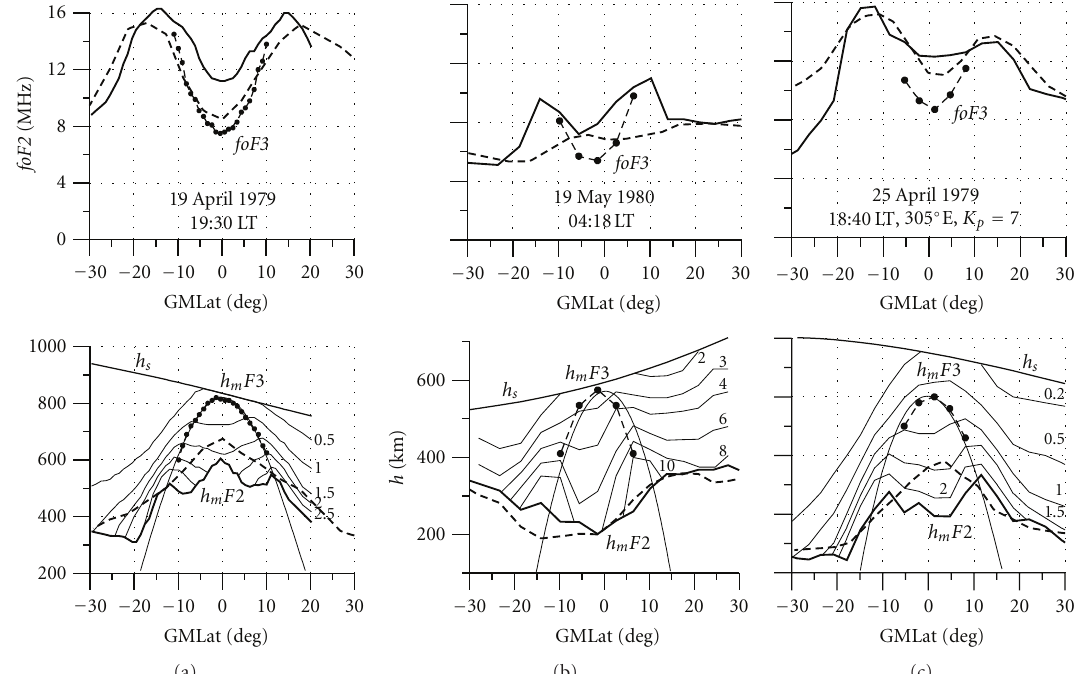
Figure 13: Latitudinal distribution of foF2 (top) for quite time on 19 April 1979 (a), 19 May 1980 (b), and 25 April 1979 (c). Solid lines: at the ledge occurrence, thick dashed lines: without ledge on adjacent satellite passes, thin dashed lines with points: foF3 . The bottom panel shows the same for h m F2 and h m F3 . Thick lines: geomagnetic field lines, thin lines: electron density contours ( N e in 10 6 cm − 3 ), h s : satellite height. The data and local time are indicated at all plots. From Karpachev et al.